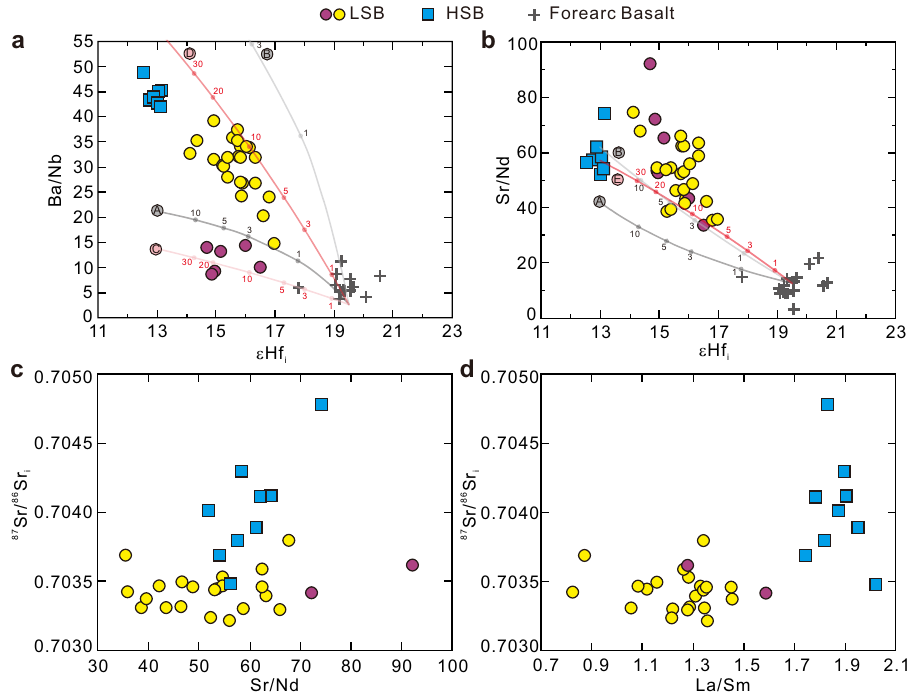
Fig. 4 Radiogenic isotopes and trace element systematics of the Expedition 352 boninites. Plots of a Ba/Nb and b Sr/Nd versus ε Hf i and 87 Sr/ 86 Sr i versus c Sr/Nd and d La/Sm for International Ocean Discovery Program Expedition 352 forearc basalt and boninites. The mixing curves in a and b are between the depleted mid-ocean ridge basalt mantle 49,64 and the calculated granulite melts (F = ~10%). A : Basaltic protolith low Ba/Nb granulite melts; B : Basaltic protolith high Ba/Nb granulite melts; C : Gabbroic protolith low Ba/Nb granulite melts; D : Gabbroic protolith high Ba/Nb granulite melts; E : Melts of gabbroic protolith granulite with its original Sr/Nd. The numbers on the mixing curves represent the mass percentage of the slab melt. The forearc basalt data are from Li et al. 4 . LSB: low-silica boninite; HSB: high-silica